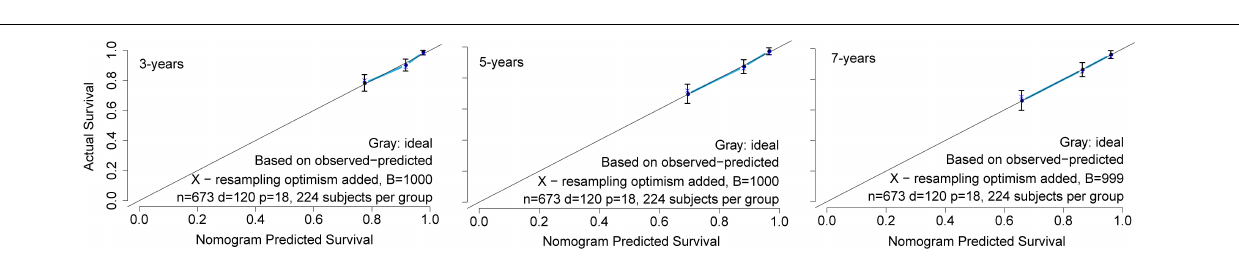
the areas under the curve (AUCs) of the risk score for 3-, 5-, and 7-year survival were 0.775, 0.776, and 0.772, respectively, which were higher than those of all of the clinical factors in the nomogram ( Figures 4A–C ). Patients with a high-risk score had a markedly worse OS than patients with a low-risk score (log-rank test P < 0.0001, Figure 4D